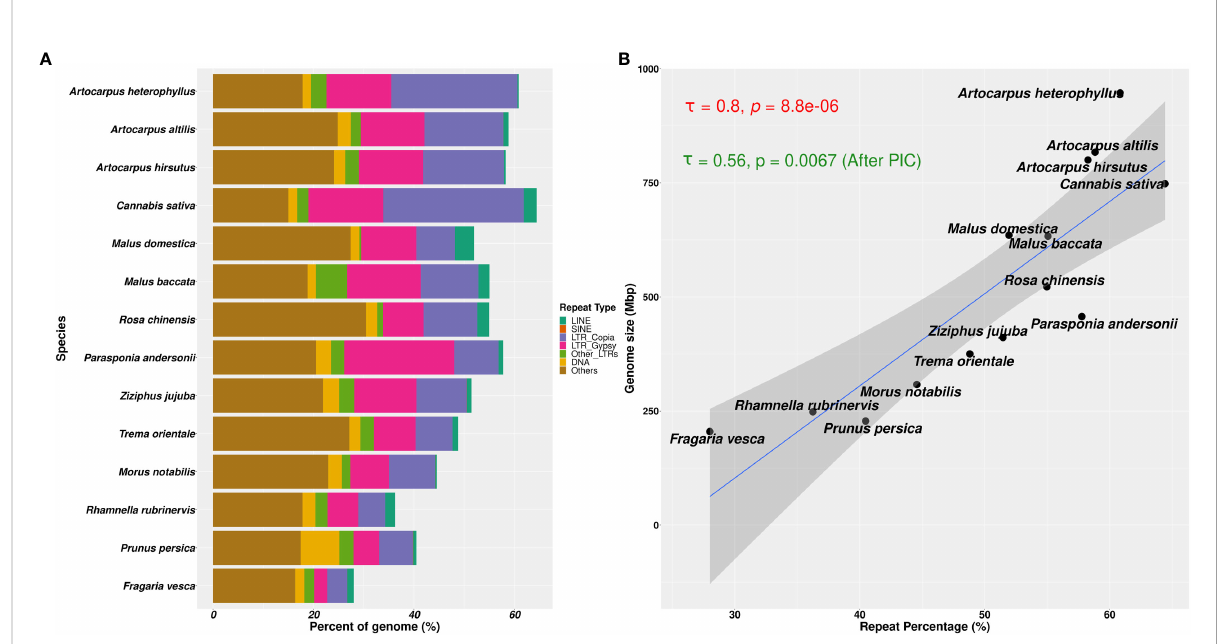
FIGURE 5 Repetitive genomic regions and their abundance in Rosales genomes. (A) Repeat content percentages in genomes of 14 species of Rosales with the abundance of types of repeats across these species. (B) Correlation of genome sizes with percentage of repeat content assembled in these 14 genomes. There is a strong positive correlation ( t = 0.8 and p-value = 8.8e-06, after Phylogenetically Independent Contrasts (PIC): t = 0.56 and p-value = 0.0067) between the percentage of repeat sequences assembled in the genome and the assembly